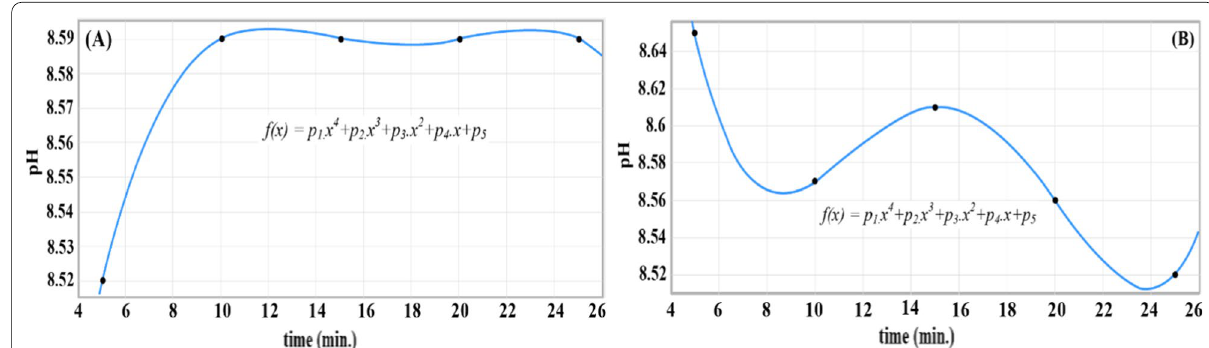
Fig. 12 pH versus time, by using brackish groundwater in case of closed cycle: A at flow rate of 52.16 l/min and B at flow rate of 12.32